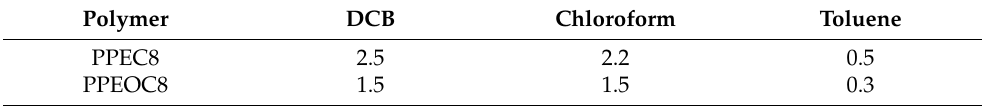
Table 1. Maximum solubility (mg/mL) of SWNTs in various solvents by PPE wrapping (a) . Polymer